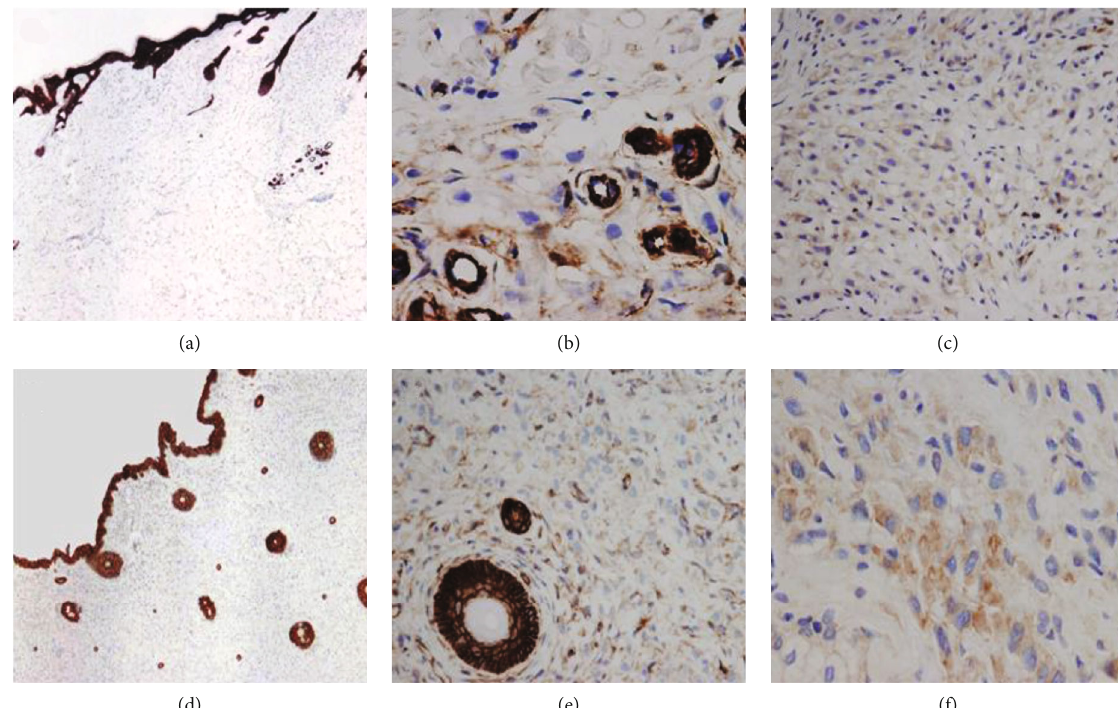
Figure 4: Case 1: (a) neoplastic cells show loss of E-cadherin expression (4x); (b) weak heterogeneous membranous staining for β -catenin is seen focally (20x); (c) low cytoplasmic expression of Src (10x). Case 2: (d) tumor cells depicting loss of E-cadherin expression (4x); (e) heterogeneous, incomplete membranous staining for β -catenin is present (10x); (f) focal low cytoplasmic staining for Src in less than 25% of tumor cells